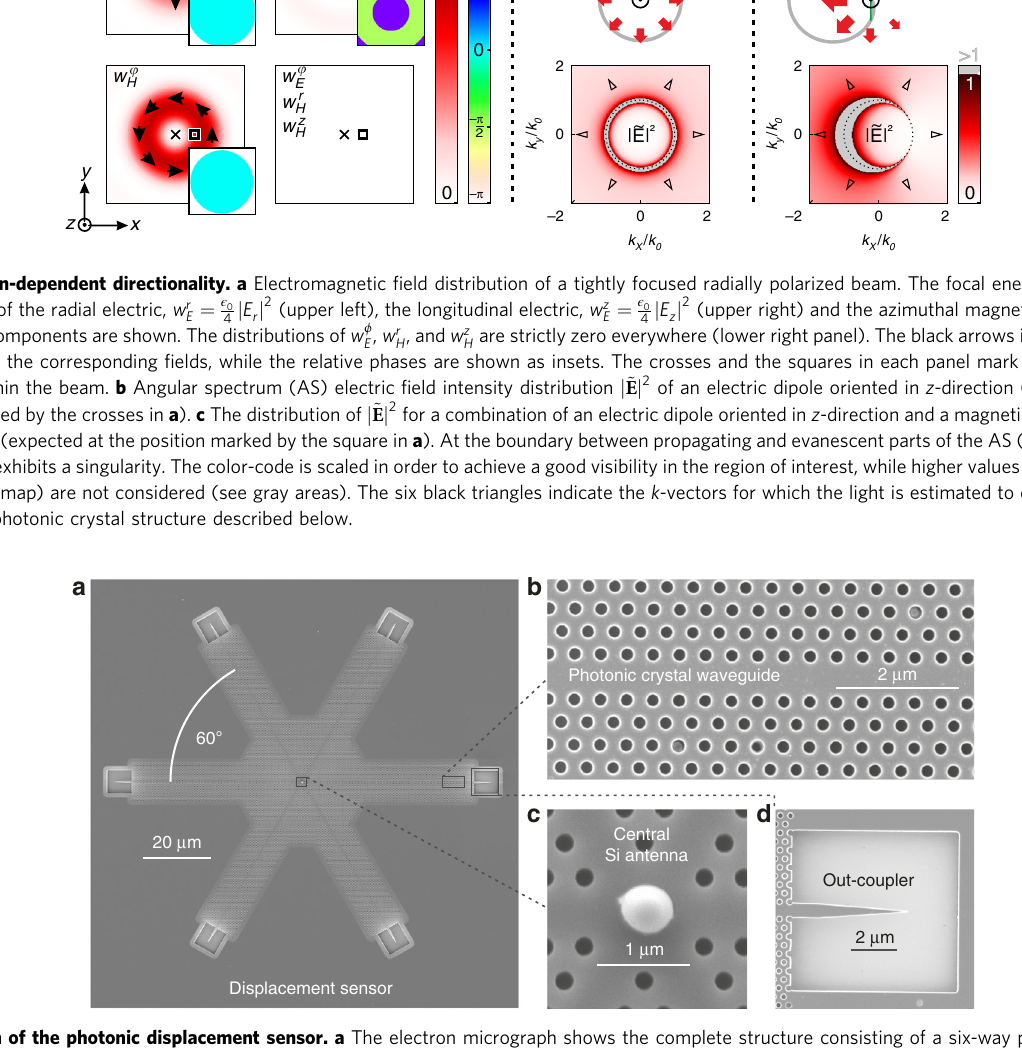
Fig. 2 Design of the photonic displacement sensor. a The electron micrograph shows the complete structure consisting of a six-way photonic crystal waveguide crossing (see waveguide section in b ), a Si antenna with radius r ≈ 260 nm placed in the center of the crossing (depicted in c ), and six tapered out-couplers (see example in d couples light into the respective arms of the PCWs. At the end of each arm the light is coupled out of the PCWs (see magni fi ed image of the tapered coupler in Fig. 2d) and scattered into the far fi eld where it can be measured 30 . In future applications, the out- couplers can be replaced by integrated detectors 31,32 . More details